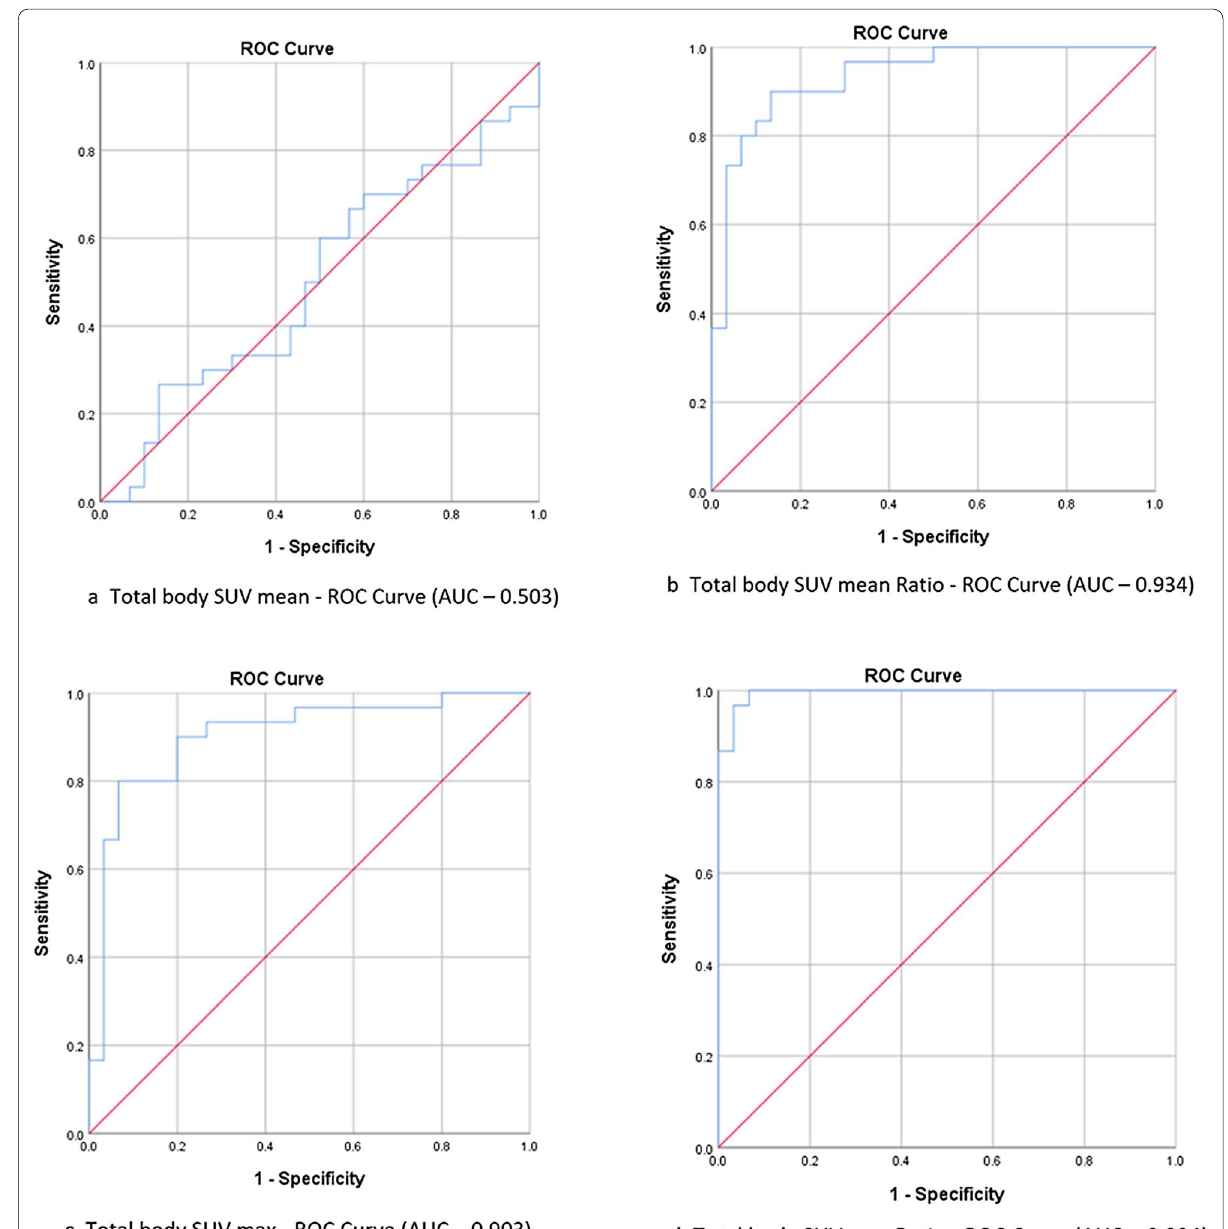
Fig. 3 a – d ROC Curves for FDG uptake in limb muscles using various parameters. e – h ROC Curves for FDG uptake in total body muscles using various